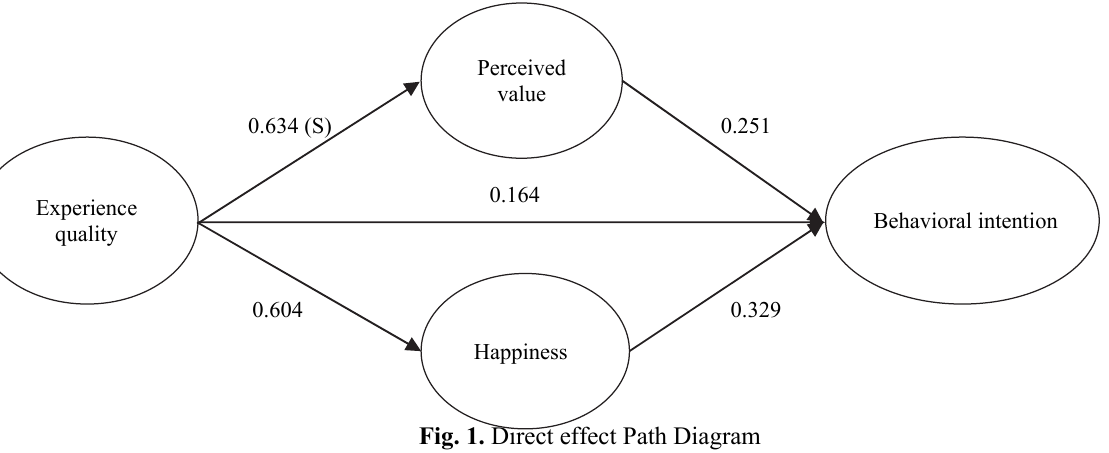
Fig. 1. Direct effect Path Diagram